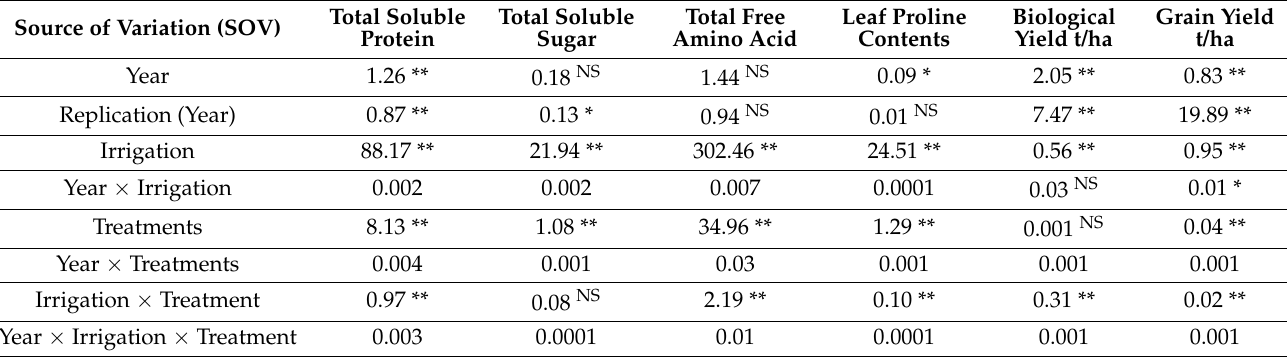
Figure 11. Effect of soil amendment materials on proline contents in the wheat crops grown under normal and water stress imposed by skipping irrigation at 4th leaf and anthesis stage of growth (mean values ± S.E). Table 2. Analysis of variance table for biochemical and yield parameters of wheat